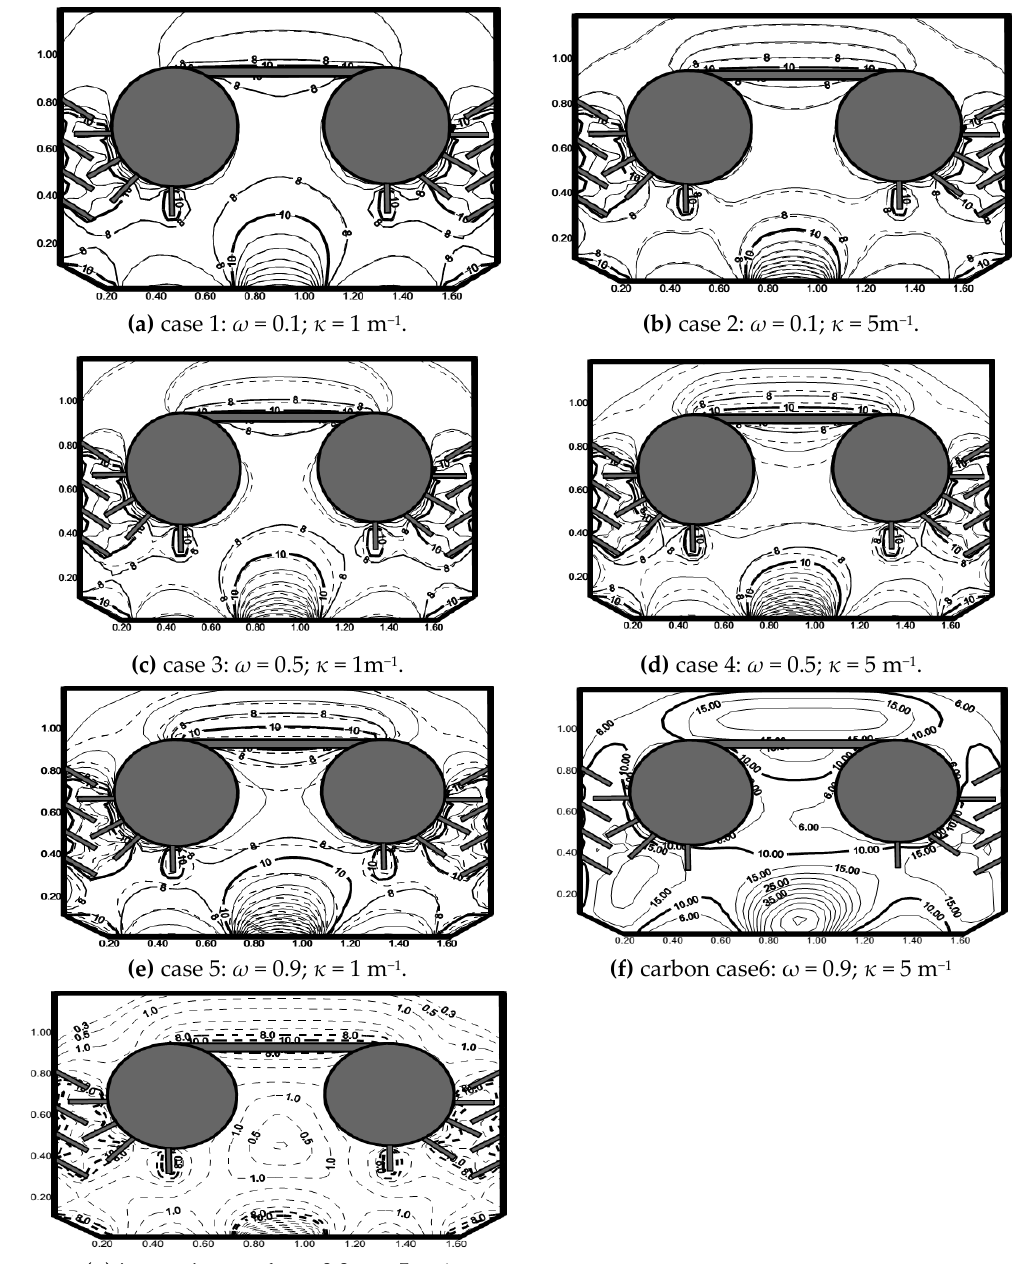
Figure 6. Effects of the absorption and albedo coefficients on the net radiation heat flux density distribution. Dashed lines: Isotropic, continuous lines: carbon. (a) case 1: ω = 0.1; κ = 1 m −1 , (b) distribution. Dashed lines: Isotropic, continuous lines: carbon. ( a ) case 1: ω = 0.1; κ = 1 m − 1 , ( b ) case 2: case 2: ω = 0.1; κ = 5m −1 , (c) case 3: ω = 0.5; κ = 1m −1 , (d) case 4: ω = 0.5; κ = 5 m −1 , (e) case 5: ω ω = 0.1; κ = 5 m − 1 , ( c ) case 3: ω = 0.5; κ = 1 m − 1 , ( d ) case 4: ω = 0.5; κ = 5 m − 1 , ( e ) case 5: ω = 0.9; κ = 1 = 0.9; κ = 1 m −1 , (f) carbon case6: ω = 0.9; κ = 5 m −1 , (g) isotropic case 6: ω= 0.9; κ = 5 m −1 m − 1 , ( f ) carbon case 6: ω = 0.9; κ = 5 m − 1 , ( g ) isotropic case 6: ω = 0.9; κ = 5 m −